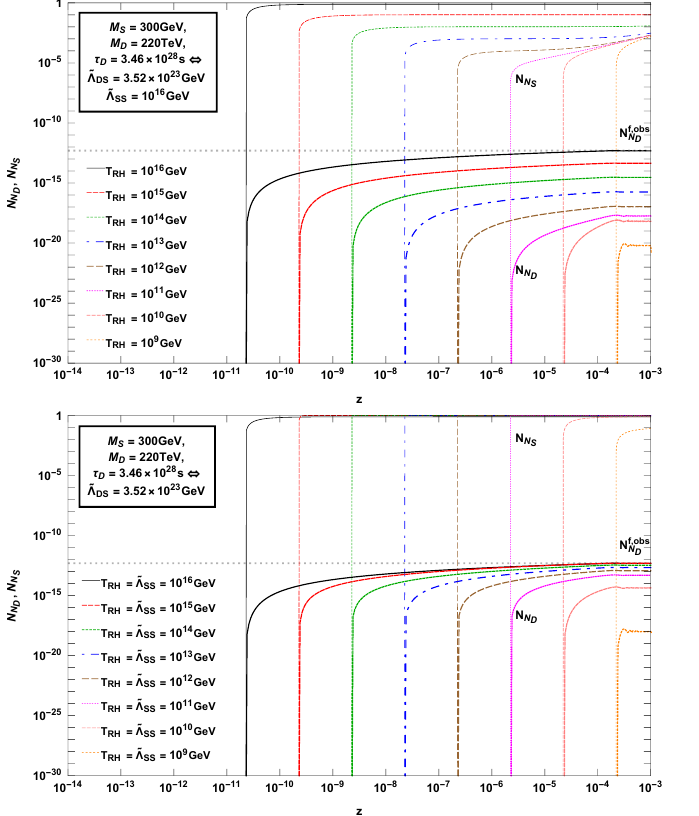
Figure 4 . Effect of source neutrino Higgs portal interactions on the source and dark neutrino